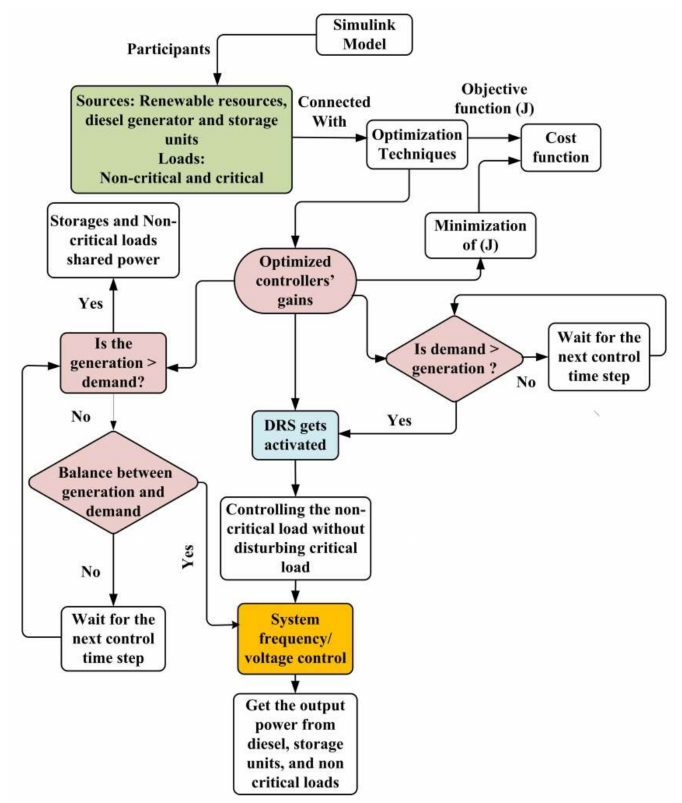
Figure 2. Structure of control strategy for renewable based